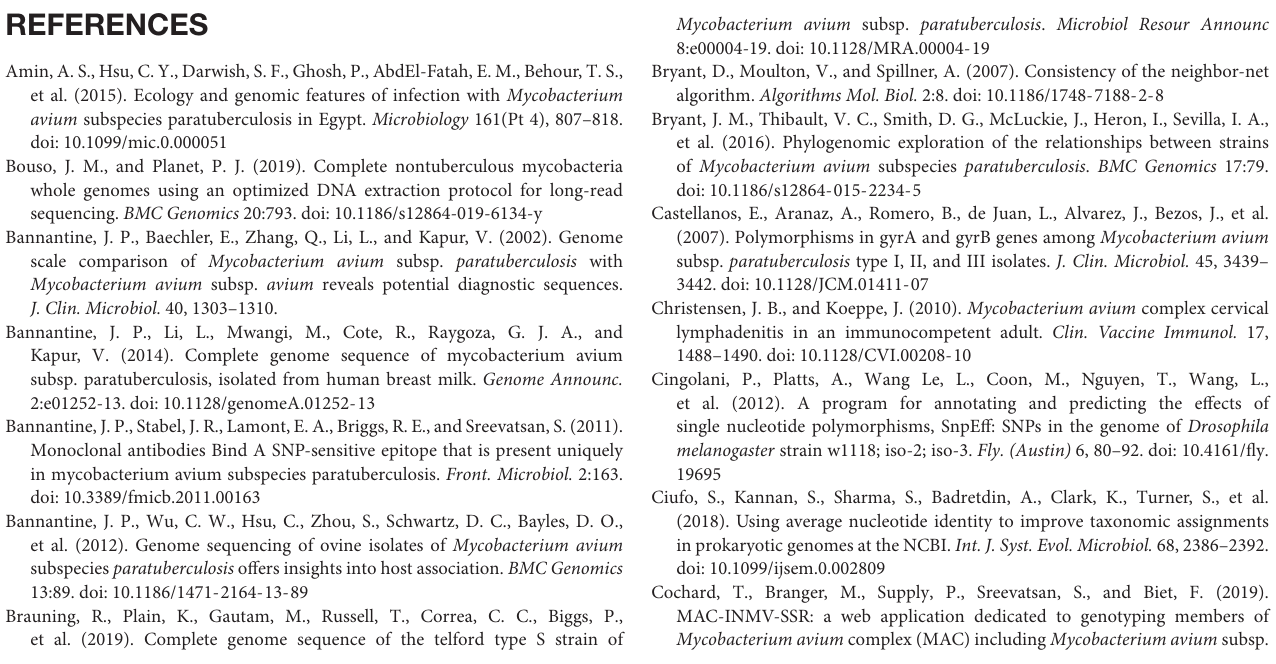
TABLE S1 | Correlation of old and new locus tags for Map K-10. Shown is a complete list of the RefSeq locus tags for Map K-10 along with the corresponding old locus tags which have been used in the scientific literature. In addition, the protein ID and description are given for coding sequences. The “NA” designation in the old locus tag column indicates a gene that was not included in the original annotation. If “NA” is present in both the old locus tag and Protein ID columns, that gene is a pseudogene.